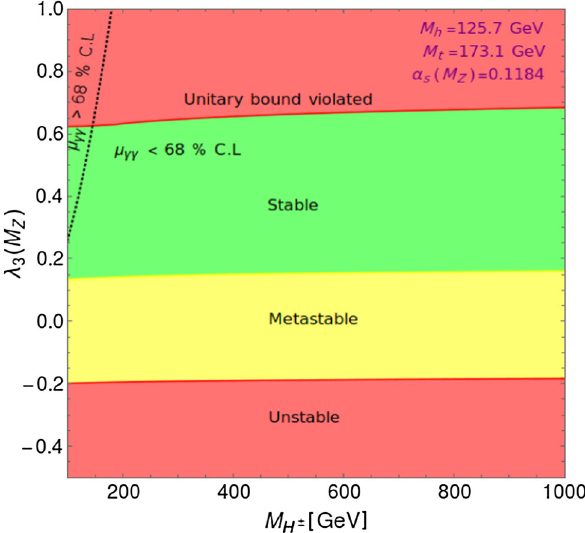
Fig. 7 Phase diagram in λ 3 ( M Z ) – M H ± plane in ITM. The right side of the black dotted line is allowed from the signal strength ratio of μ γγ within 68% confidence level and the left side is excluded at 1 σ . In the metastable region, the Higgs portal coupling λ 3 ( M Z ) is negative; however, beyond the scale (cid:14) B it is greater than